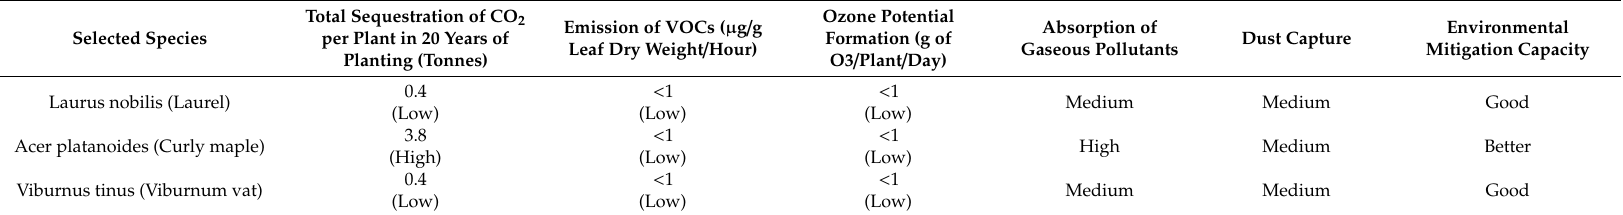
Table 5. Selected arboreal / arbustive species: potential environmental mitigation capacity.